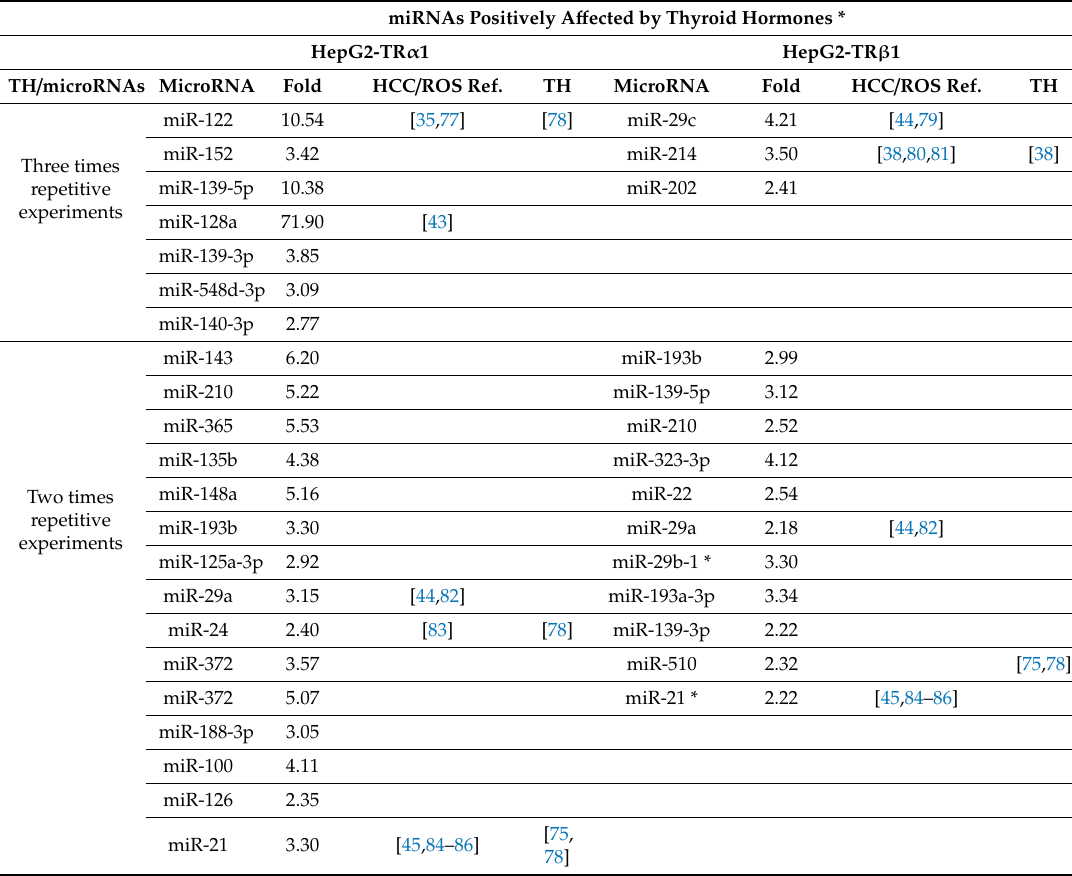
Table 2. MicroRNAs positively associated with thyroid hormones in HepG2 liver cancer cell lines. miRNAs Positively A ff ected by Thyroid Hormones * HepG2-TR α 1 HepG2-TR β 1 TH / microRNAs MicroRNA Fold HCC / ROS Ref. TH MicroRNA Fold HCC / ROS Ref.